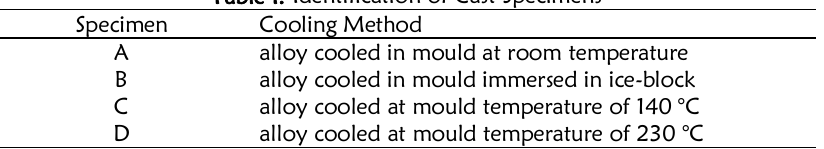
Table I: Identification of Cast Specimens